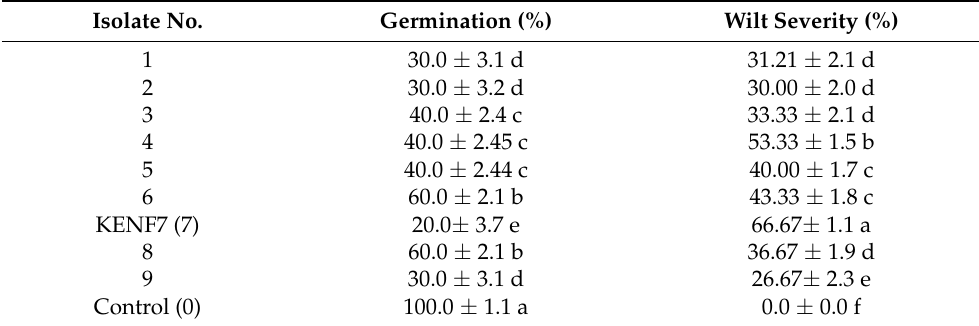
Table 1. Pathogenicity tests of nine tested fungi isolates on the Baladi cumin variety under greenhouse conditions during the 2020 season.